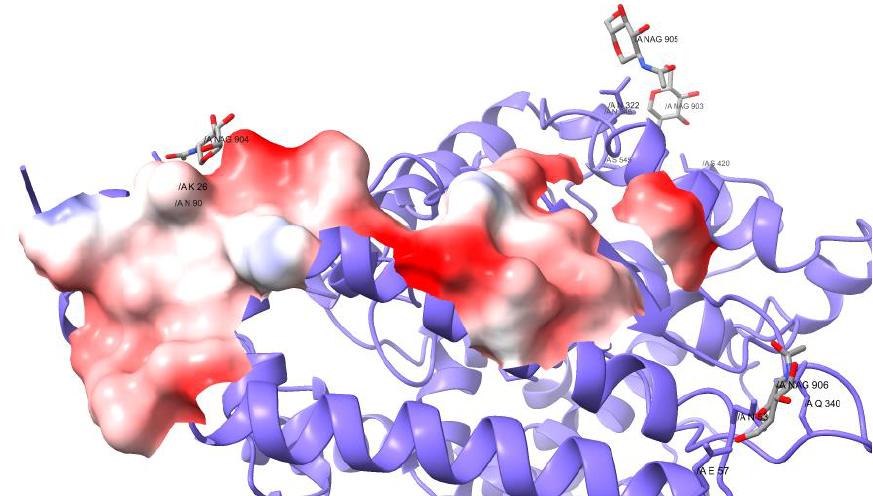
Figure 5. Electrostatic potential of the receptor ACE2 in the interacting surface with SARS2-S.